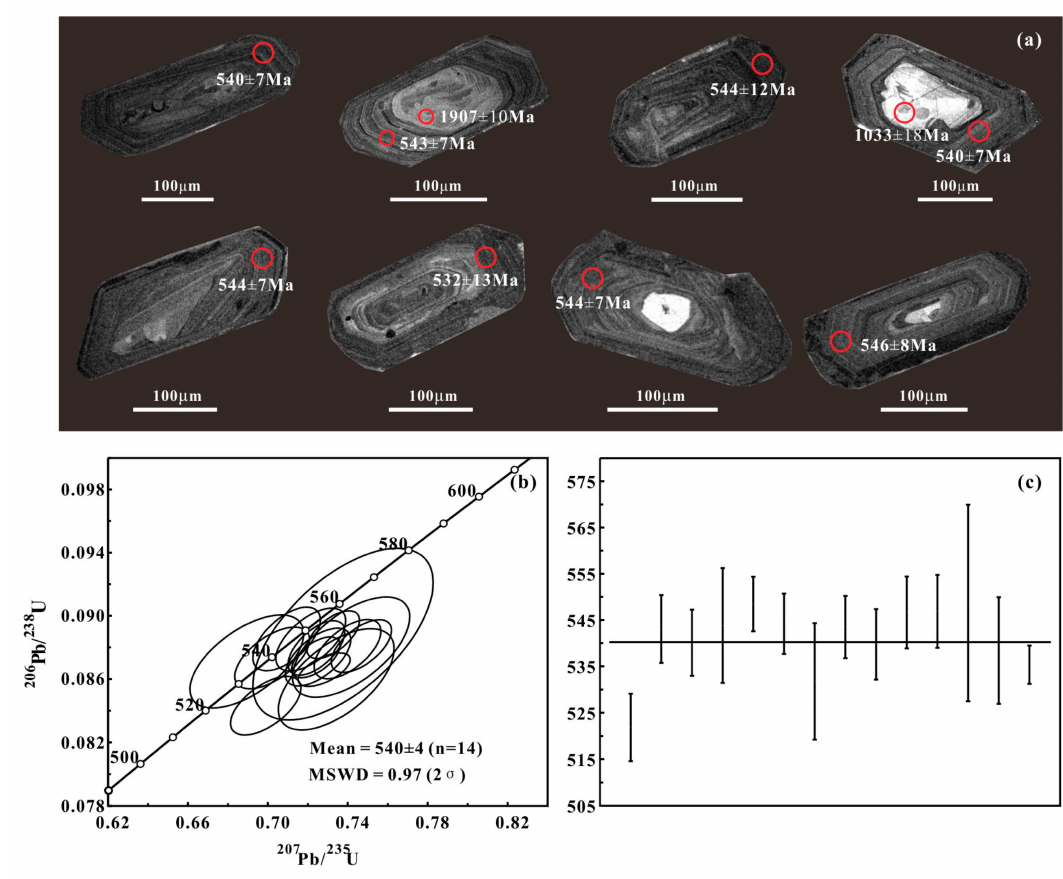
Figure 4. ( a ) Cathodoluminescence (CL) images of selected zircon grains for representative biotite granite samples, also shown are locations of analysis spots (shown as small red circles); ( b ) U–Pb concordia diagrams; and ( c ) a line graph of determined U–Pb